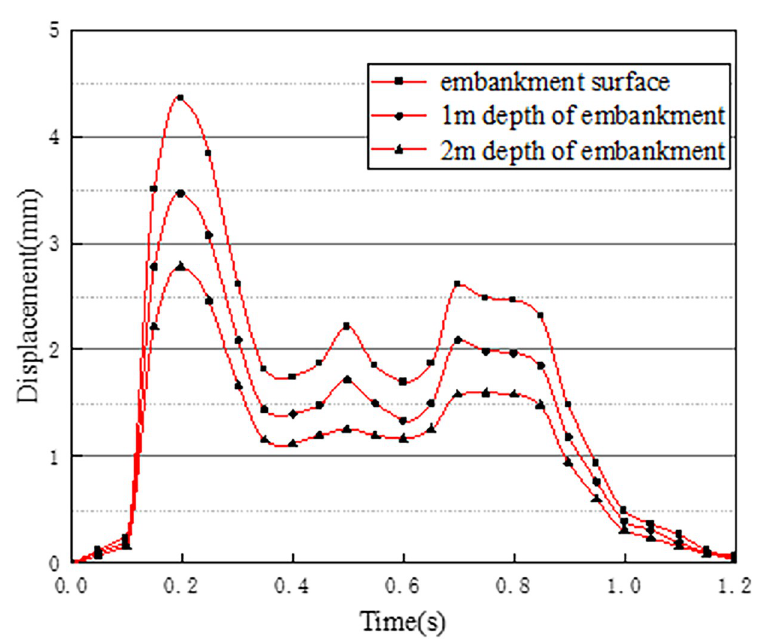
Fig 15. Displacement time history curves at different